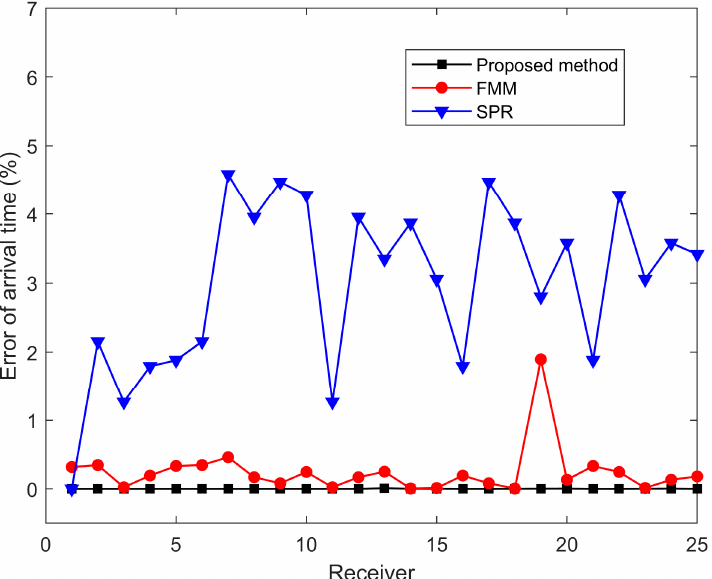
Figure 11. The relative error of the arrival time of the three methods compared to the analysis solution.